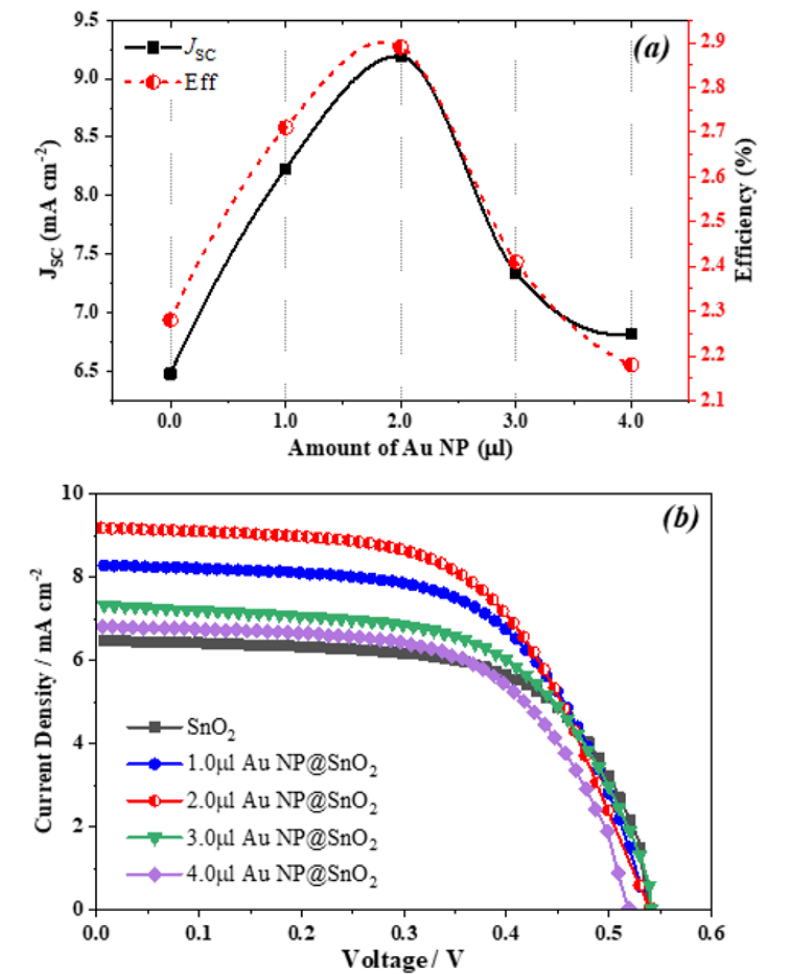
Figure 3: (a) Photocurrent density and efficiency variation of the DSSCs with respect to the amount of Au NP colloidal solution added. (b) J–V characteristics for the series of DSSCs. used to optimize the PV parameters. Table 1 : I–V characteristics of plasmonic DSSCs made with Au NP incorporated SnO gold